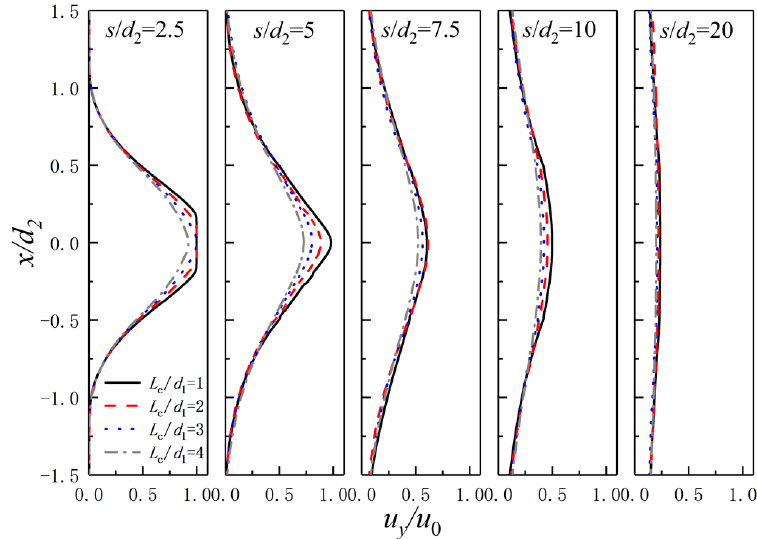
Figure 10. Velocity distribution of nozzles with different cavity lengths ( D c / d 1 = 8, L c /d 1 = 1, 2, 3, 4). When L c /d 1 = 1, the jets still maintained the initial velocity near the axis of nozzle outlet. With the development of the jets, the jet width of the initial velocity was gradually reduced. The jet turned into the transition segment where it was only maximal at the axis at s / d 2 = 5 cross-section. After entering the transition segment, the instability of jet flow increased, energy exchange took place with the surrounding fluid, which led to the rapid attenuation of the axial velocity and tended to be stable at s / d 2 = 20.